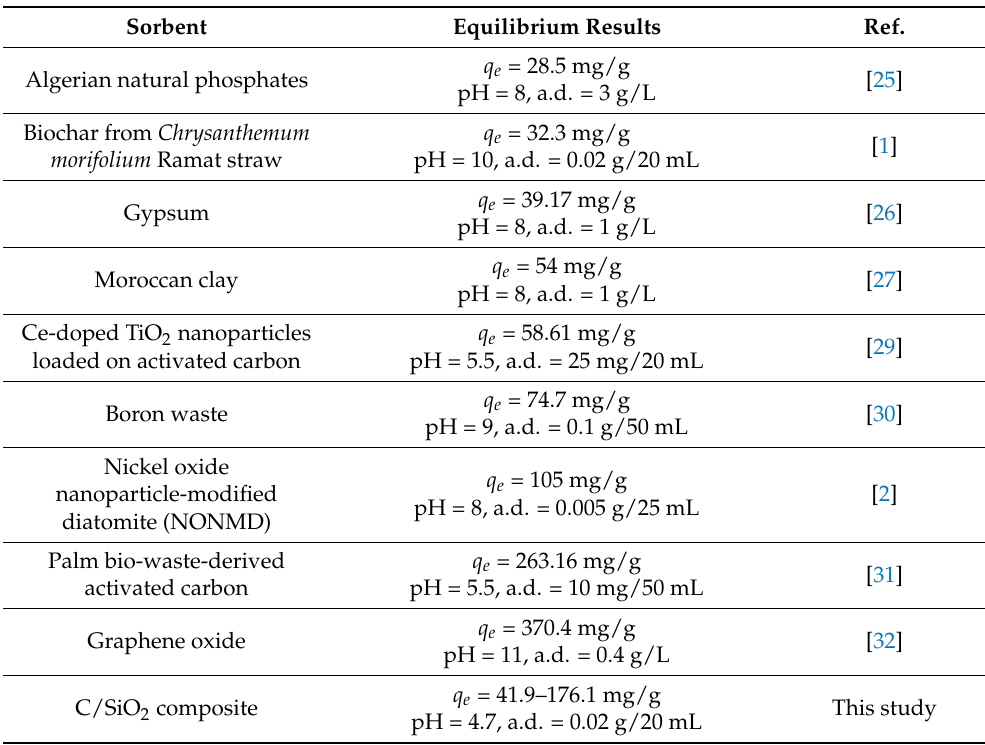
Table 2. Comparison of adsorption capacities of various adsorbents for BR46 [1,2,25–27,29–32]. Sorbent Equilibrium